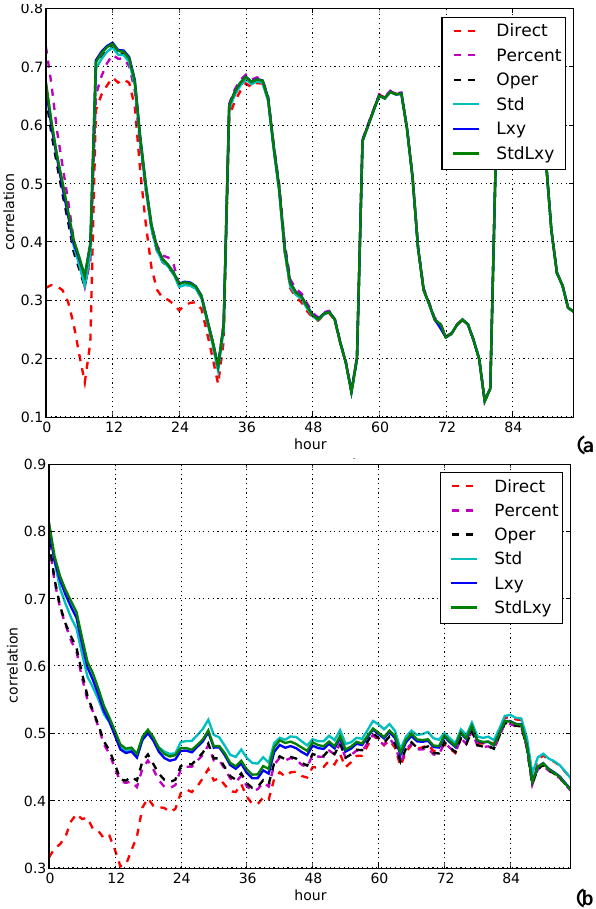
Fig. 11. Time series of the correlation between forecasts of exper- iments studied and assimilated observations, statistics on six four- days forecasts in the period between 1 and 10 July 2010 (a) and 1 and 10 December 2010 (b)